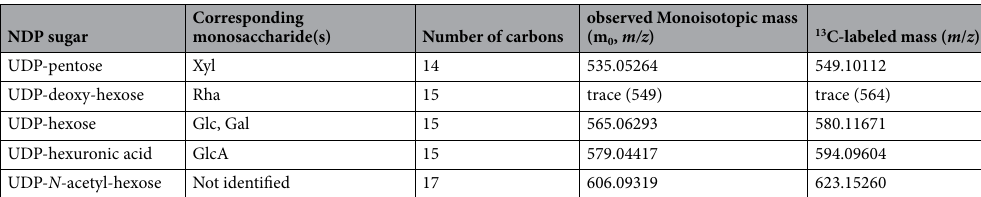
Table 1. Accurate mass analysis of nucleic diphosphate sugars by